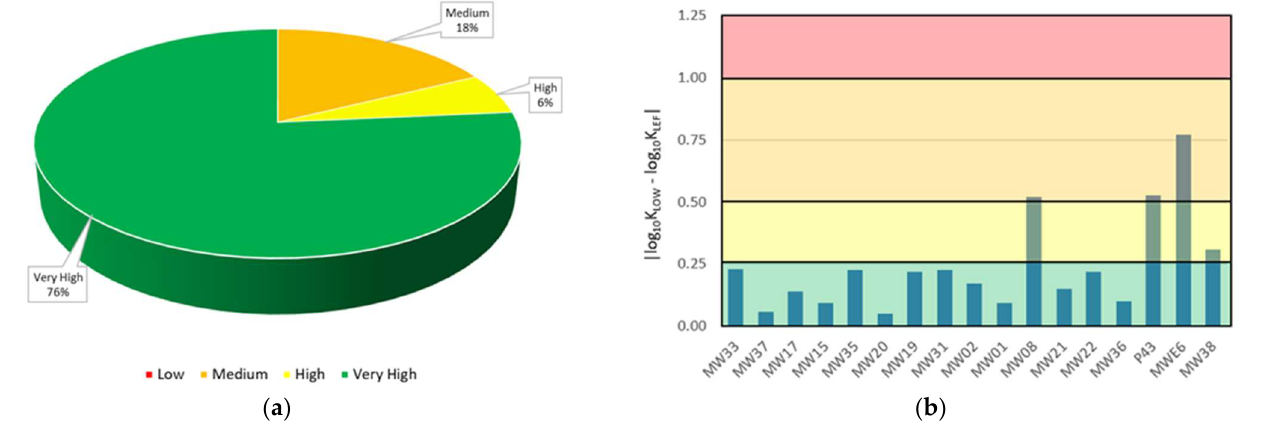
Figure 5. Correlation results between permeability values estimated with the low-flow methodology (K LOW ) and values obtained with the LeFranc tests (K LEF ).